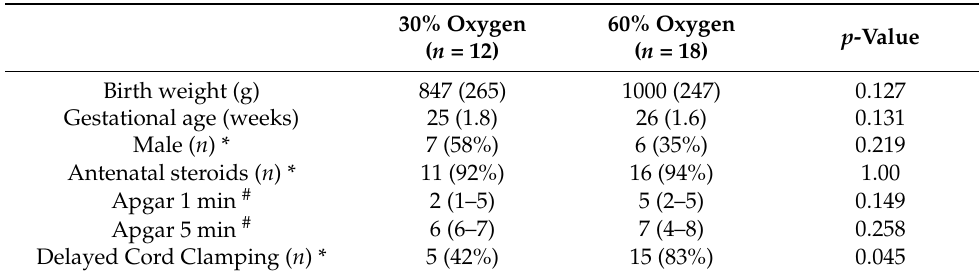
Figure 2. Consort–diagram. Table 1. Demographics of study